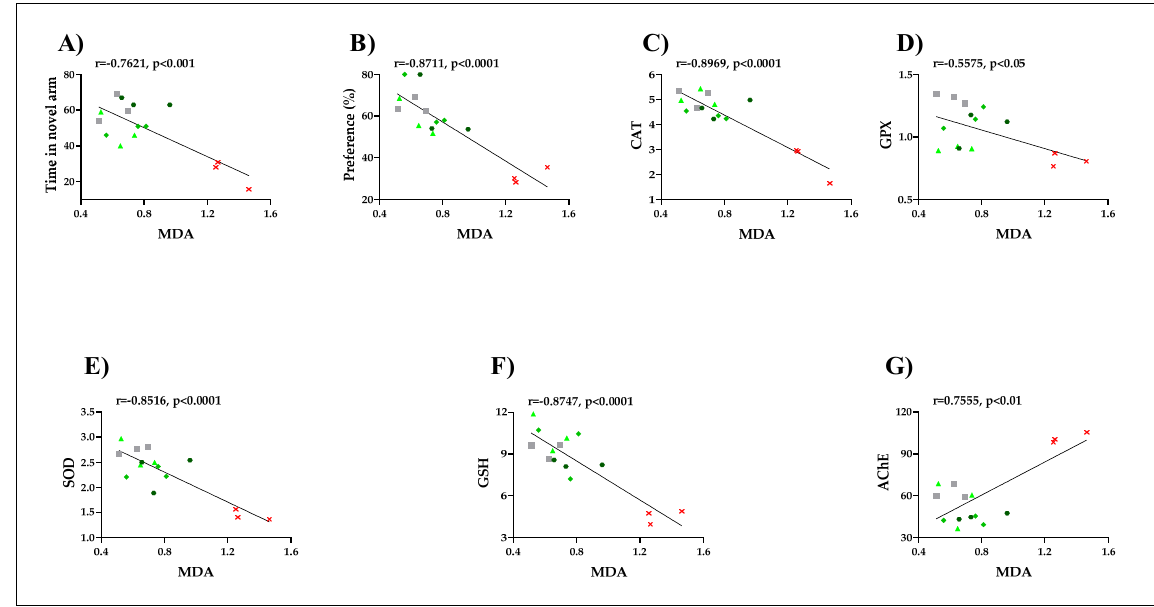
Figure 6. Correlation analyses between behavioral and biochemical parameters (Pearson’s correlation, n = 10): ( A ) Time in novel arm (% of total time) vs. MDA: r = − 0.7621, p < 0.001; ( B ) Preference (%) vs. MDA: r = − 0.8711, p < 0.0001; ( C ) CAT vs. MDA: r = 0.8969, p < 0.0001; ( D ) GPX vs. MDA: r = − 0.5575, p < 0.05; ( E ) SOD vs. MDA: r = − 0.8516, p < 0.0001; ( F ) GSH vs. MDA: r = − 0.8747, p < 0.0001; ( G ) AChE vs. MDA: r = − 0.7555, p < 0.01. Data expressed are time in the novel arm (% of total time), time in the novel arm (s), SOD (U/mg protein), CAT (U/mg protein), GPX (U/mg protein), GSH ( μ g GSH/ μ g protein), AChE (nmol/min/mg protein), and MDA (nmol/mg protein).